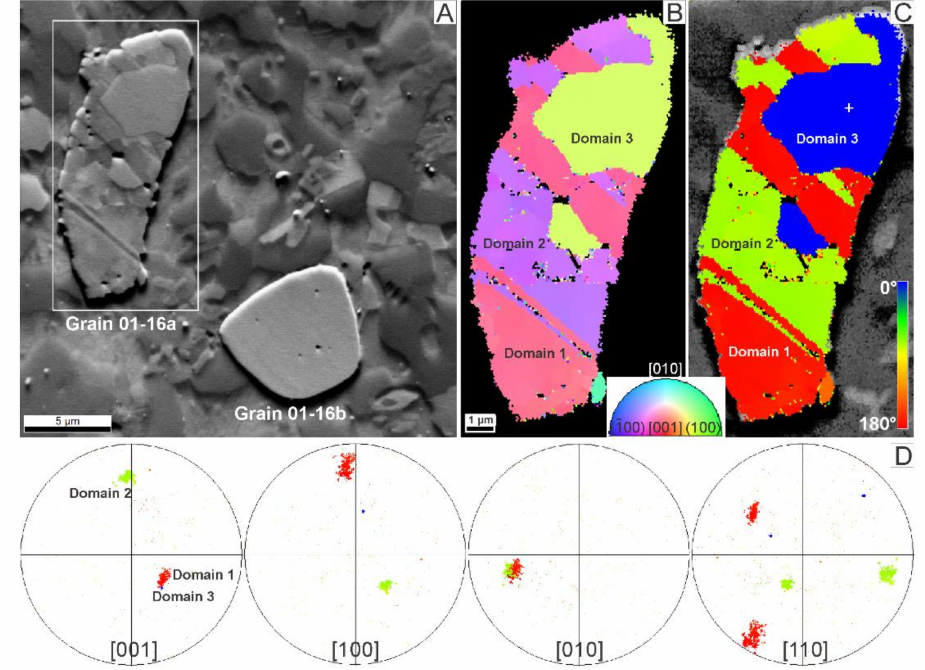
Figure 12. Microstructural details of the monazite grain 01-16a, located at 0.5 mm from the PT vein. ( A ) Orientation contrast (FSE) image, showing deformed (01-16a) and undeformed (01-16b) monazite grains. Box shows the area mapped in ( B , C ). ( B ) EBSD map, color-coded in the IPF colors. ( C ) EBSD map color-coded according to misorientation with respect to the user-selected reference point ( + ). Misorientation is shown from 0 ◦ (blue) to 180 ◦ (red). Step size 80 nm. ( D ) Upper hemisphere equal angle projection pole figures for [001], [100], [010], and < 110 > axes, color-coded as in ( C ). Plotted with the EDAX OIM v7.3 Analysis